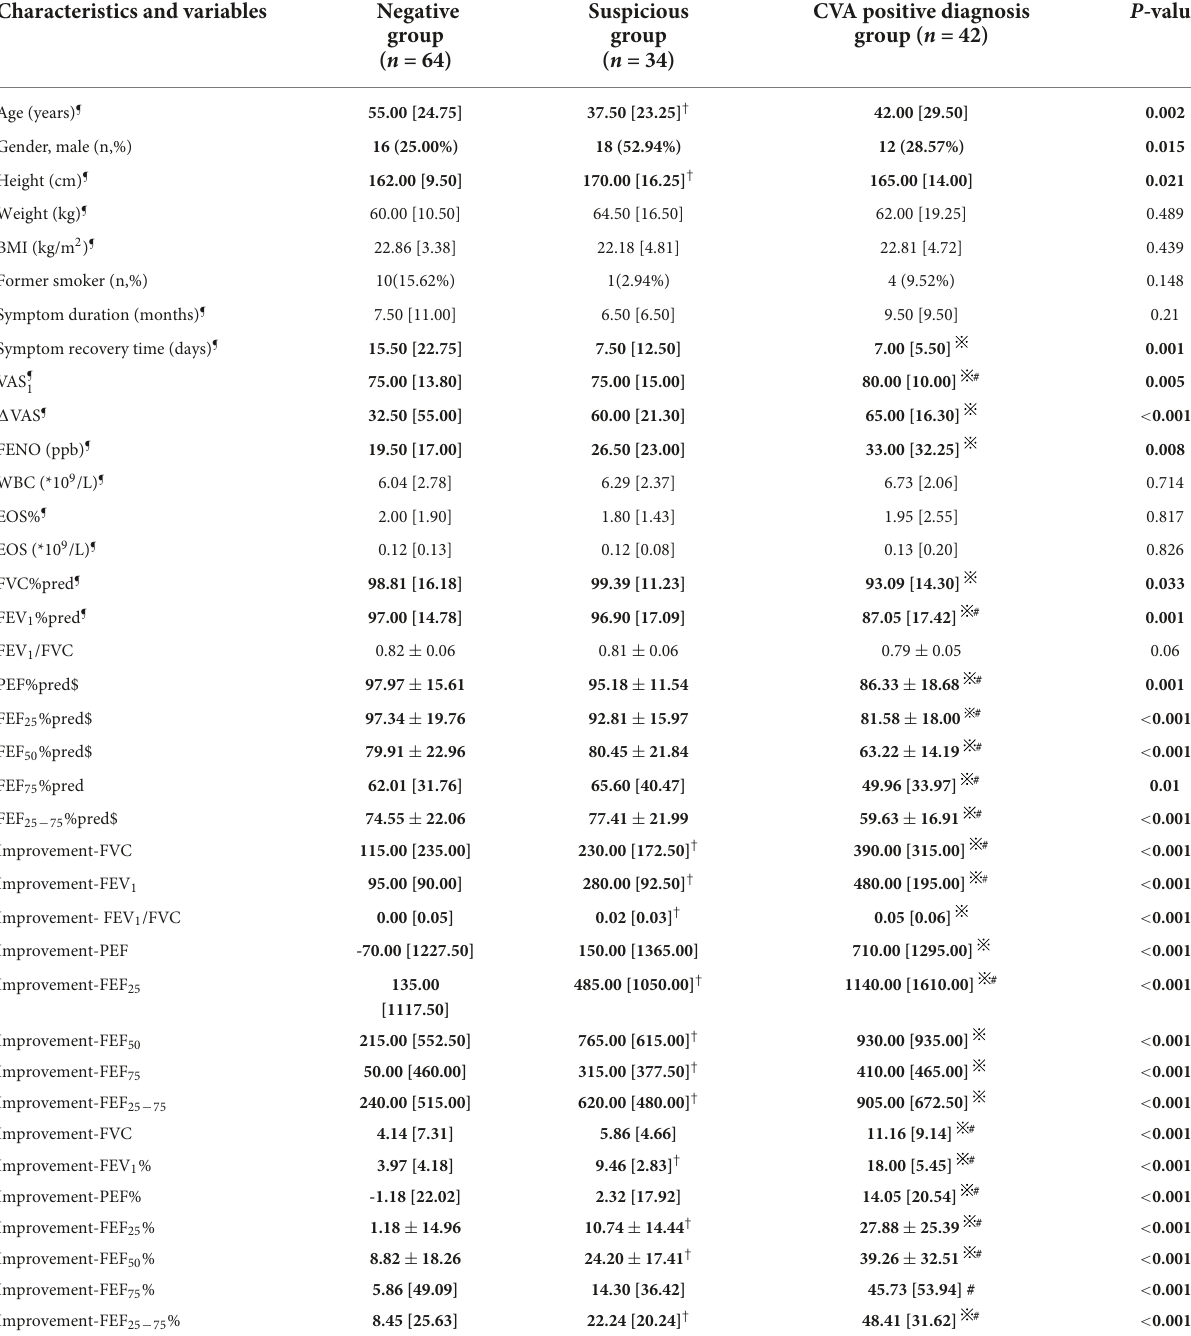
TABLE 4 Demographic data and clinical features of study participants in the negative group, suspected group, and CVA positive diagnosis group. Characteristics and variables Negative